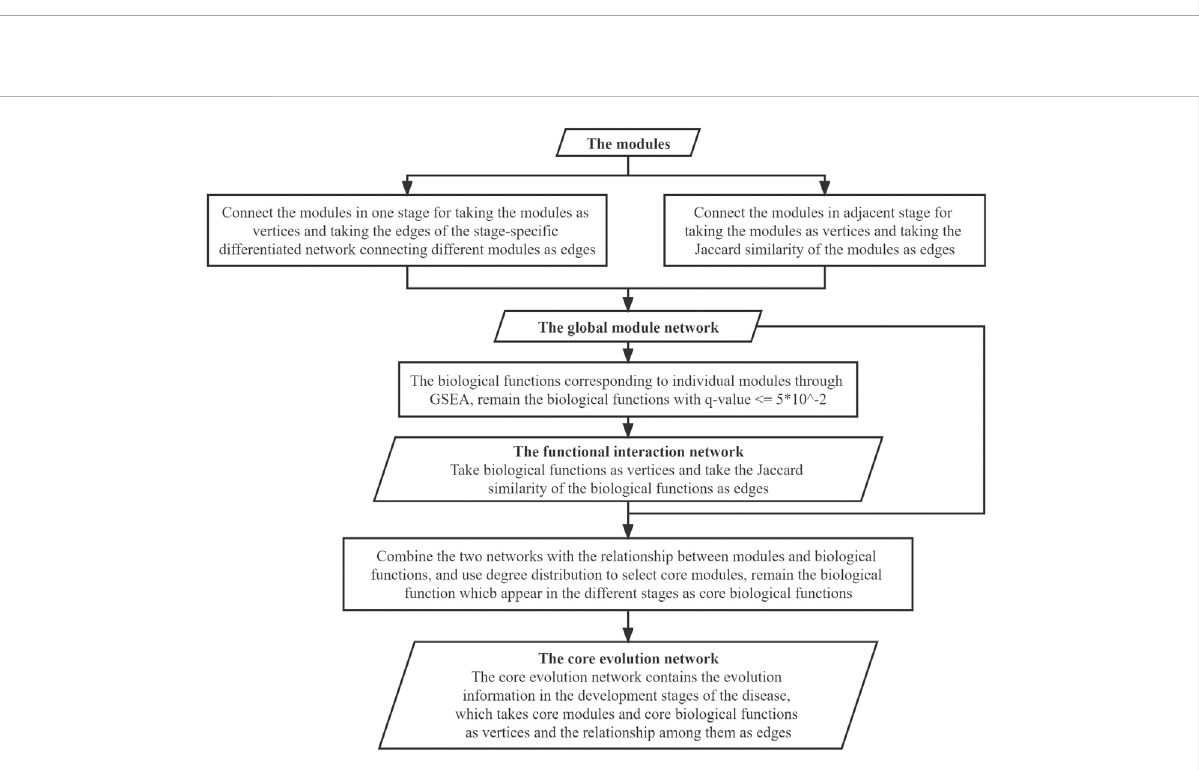
FIGURE 6 Flowchart for building the core